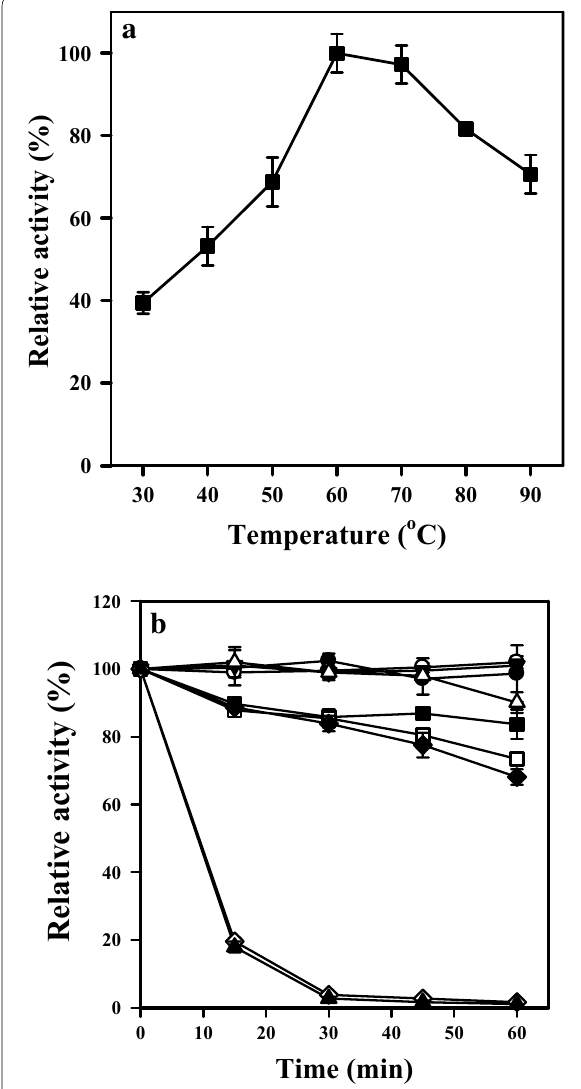
Fig. 1 a Effect of pH on KerP activity. b pH stability of KerP. Enzyme activity was preserved at various pH levels between 0 and 48 h before assaying enzyme activity. pH 5.0 (filled circle), pH 6.0 (open circle), pH 7.0 (filled inverted triangle), pH 8.0 (open triangle), pH 9.0 (filled square), pH 10.0 (open square), pH 11.0 (filled diamond), pH 12.0 (open diamond). The enzyme activity was assayed with feather powders as the substrate at 60 °C for 1 h